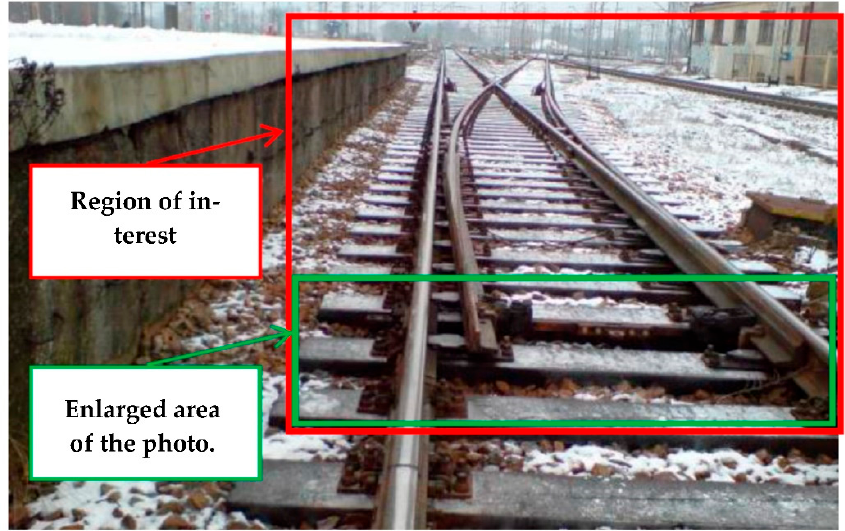
Figure 1. Photo showing a fragment of the track layout (source: authors).